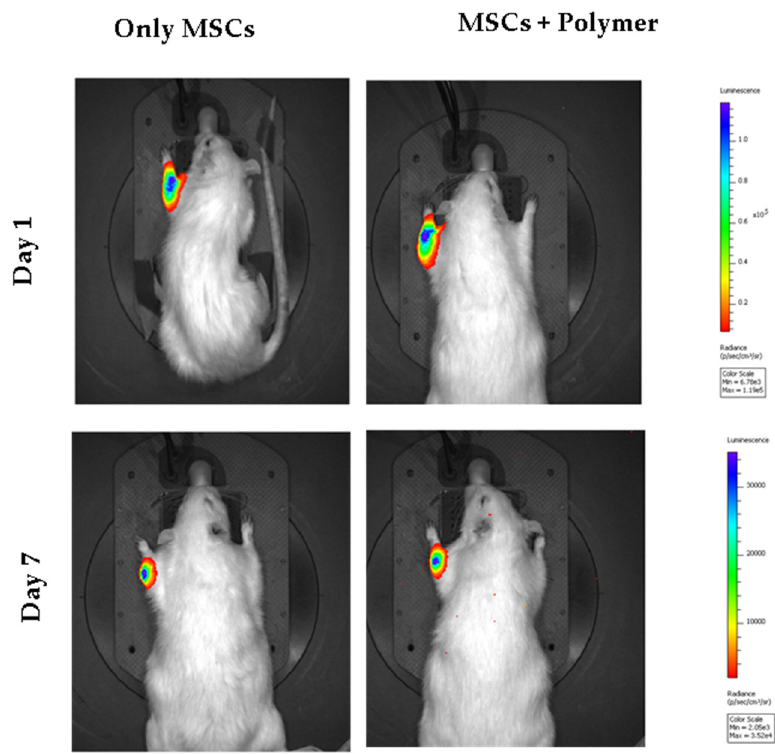
Figure 6. Bioluminescent analysis of the transplanted cells of the group that received MSCs only and polymer-coated MSCs. MSCs (1.0 × 10 6 cells/mL) were transfected with firefly luciferase lentiviral particles (LVT-Luc2). Before analysis, luciferin was injected at a dose of 10 µL/g. Bioluminescence analysis was performed after 20 min.